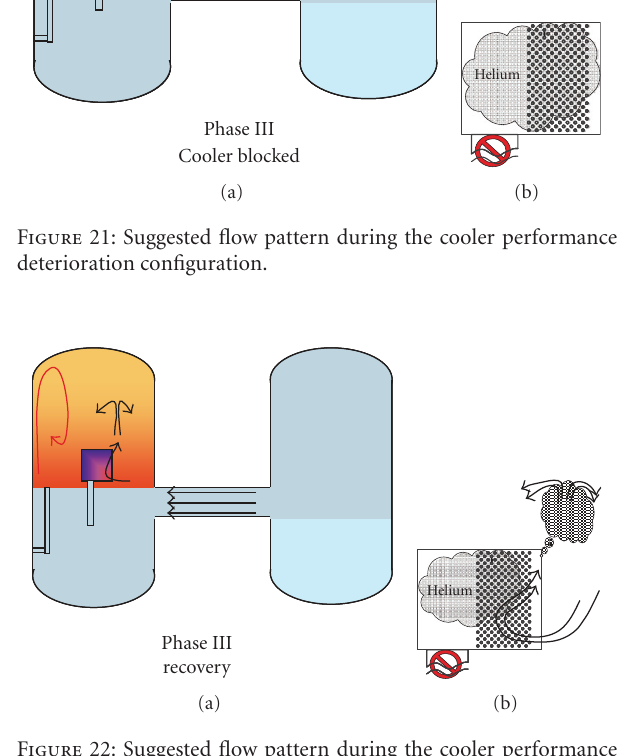
Figure 22: Suggested flow pattern during the cooler performance recovery configuration.